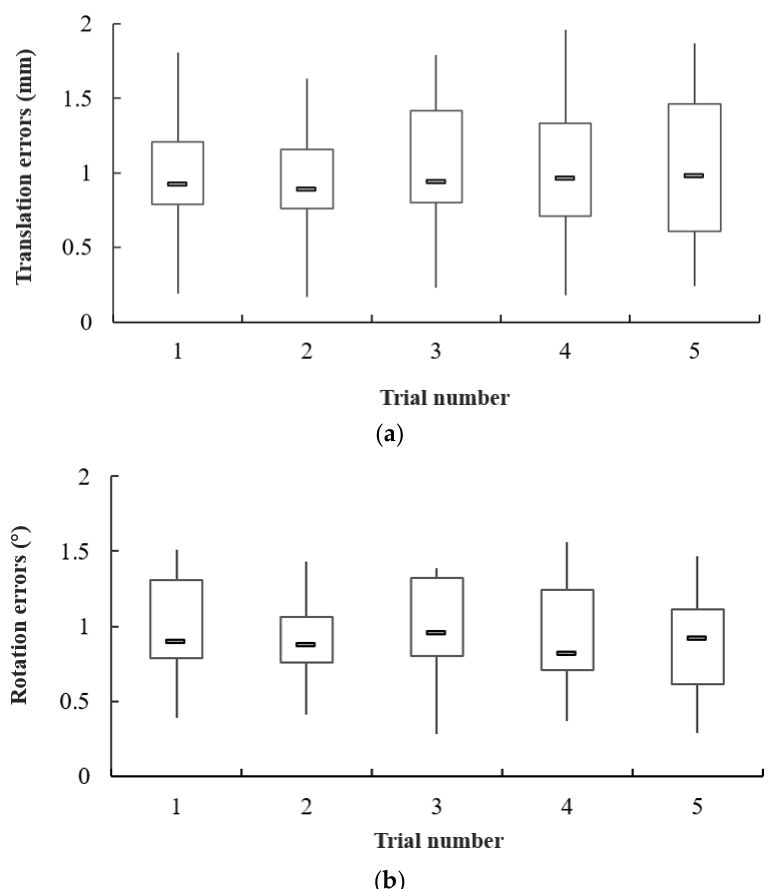
Figure 14. Experimental results for tracking performance between master side and slave side: ( a ) the result for translation over 5 trials; ( b ) the result for rotation over 5 trials.